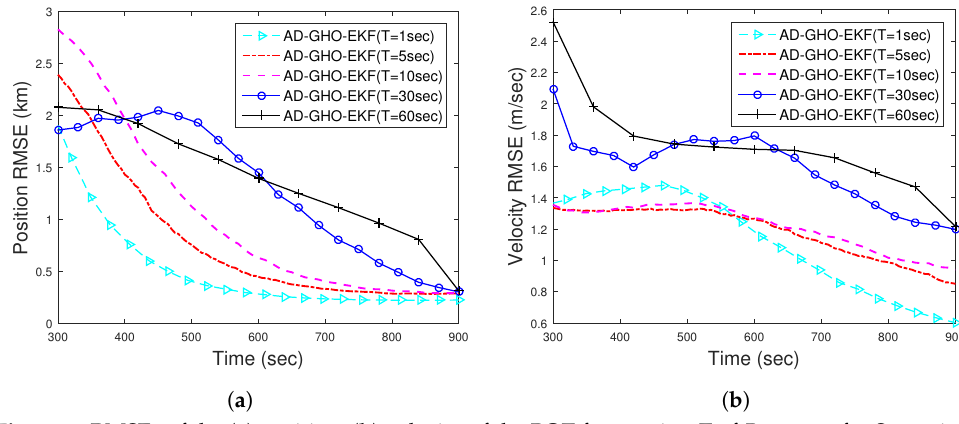
Figure 8a,b show the position and velocity RMSEs for DBT obtained from square root filters and orthogonal polynomial filters out of 500 MC runs. They are calculated with known R = ( 1.5 ◦ ) 2 , excluding track divergence cases. All the RMSEs are comparable and lower than the RMSE obtained from BOT. The ANEES with the 500 m track loss threshold are within the provided probability region. The position bias norms of the filters approach zero and are much below that of BOT. From these figures (Figures 8 and 9), we can conclude that the filters with DBT measurements track more effectively than those with BOT